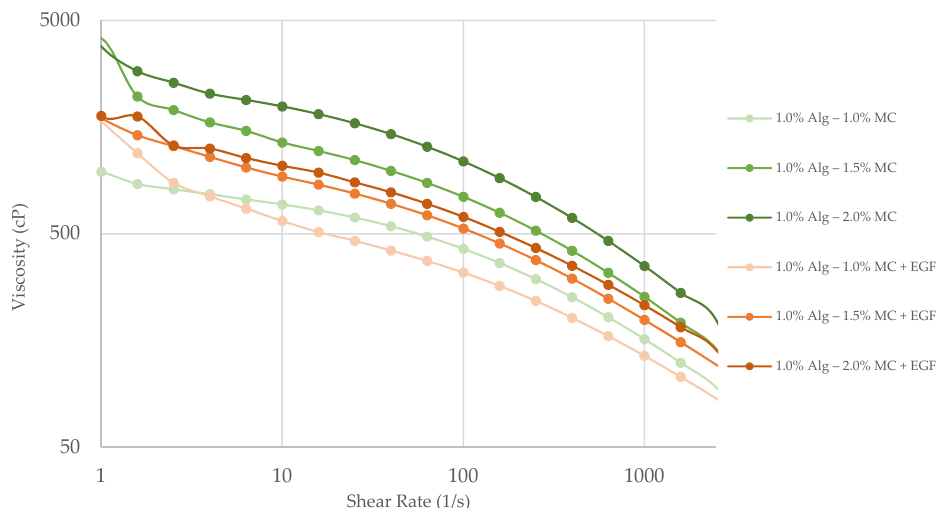
Figure 4. Shear viscosity behavior of alginate-methylcellulose mixtures (green) with varying methylcellulose concentrations (% w/v ) and epidermal growth factor (EGF) addition at 3.33 mg/mL (red). The circular symbols appearing in the plots represent the mean-values of discrete measurements evenly acquired at logarithmic intervals under steady-state conditions, while the continuous lines are guides for the eye.